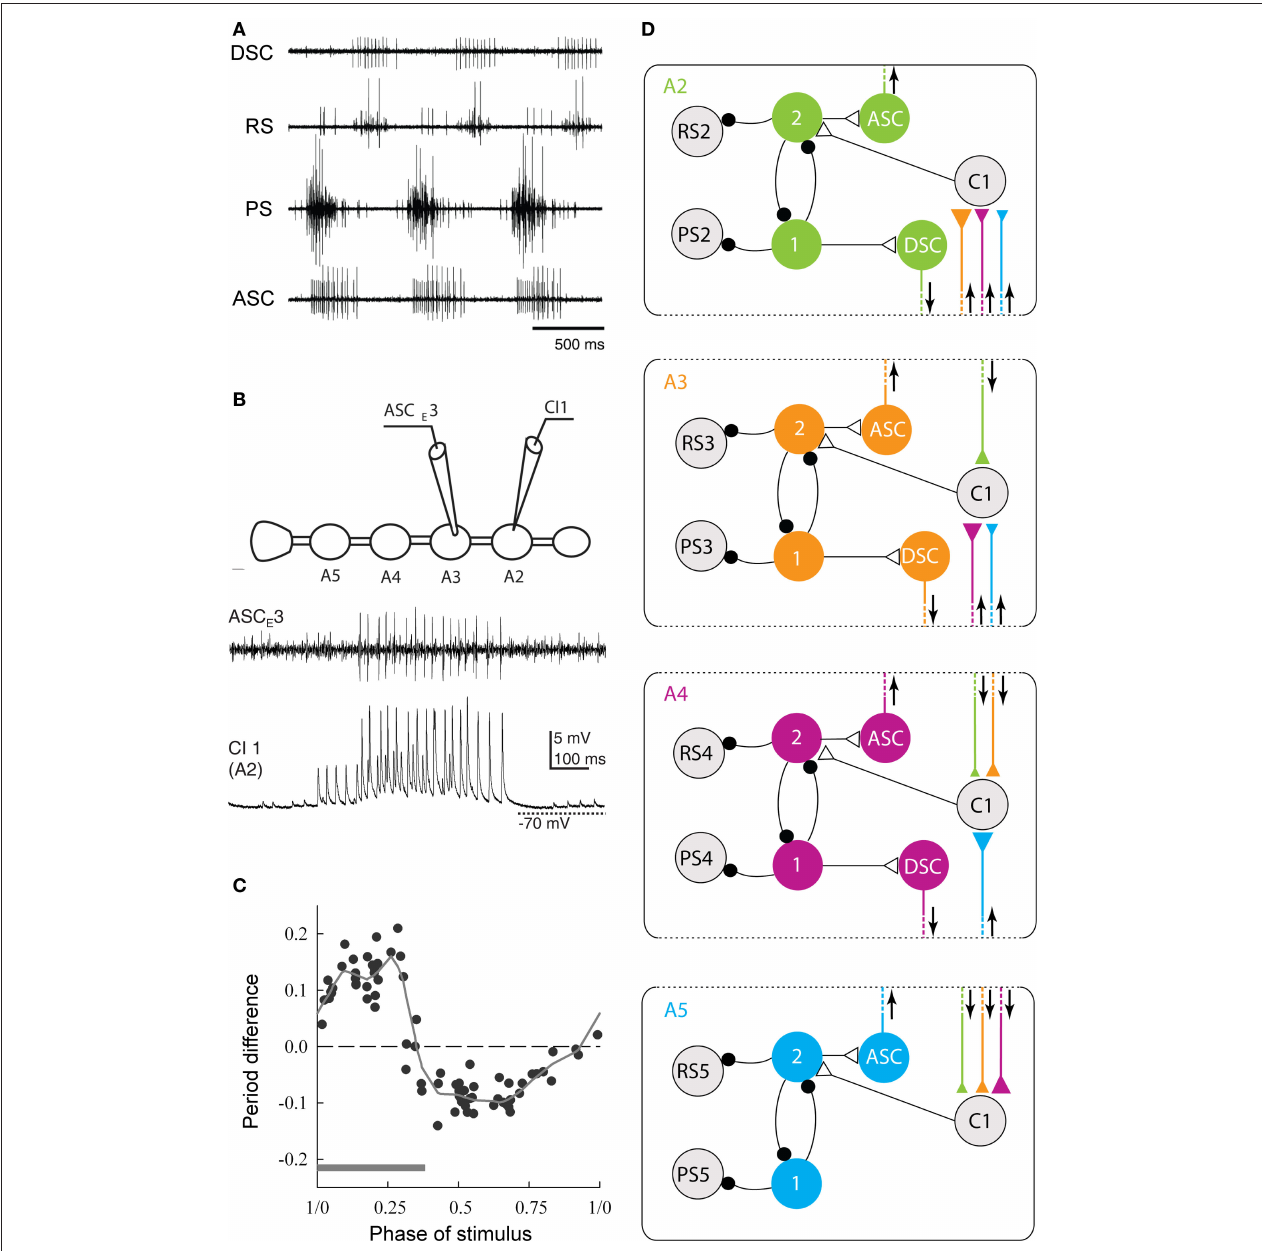
output. Here, phase is defined as the point in the cycle of PS–RS alternation at which the stimulus began. Stimuli early in a cycle, during the PS burst (gray bar), prolong the period of the cycle, but later stimuli shorten the period. The period difference is the difference between the measured period and the expected period if the stimulus had no effect. The dotted horizontal line marks zero change. The solid line is a “locally weighted estimate” fit to the data (Smarandache et al., 2009). (D) A diagram of the circuit that coordinates local pattern-generating circuits in ganglia A2, A3, A4, and A5. In each ganglion, local interneurons (1, 2) determine when the PS and RS motor neurons fire. In each ganglion, an ASC and a DSC neuron encode information about the PS and RS E activity and conduct it to other ganglia. This information converges onto ComInt 1 neurons (C1) that synapse onto one of the local pattern-generating neurons. Colors mark the ganglion in which each coordinating axon originates. Triangles symbolizes excitatory synapses; larger triangles mark relatively stronger synapses. Small black circles symbolize inhibitory synapses. Arrows show the direction of impulse conduction in each coordinating